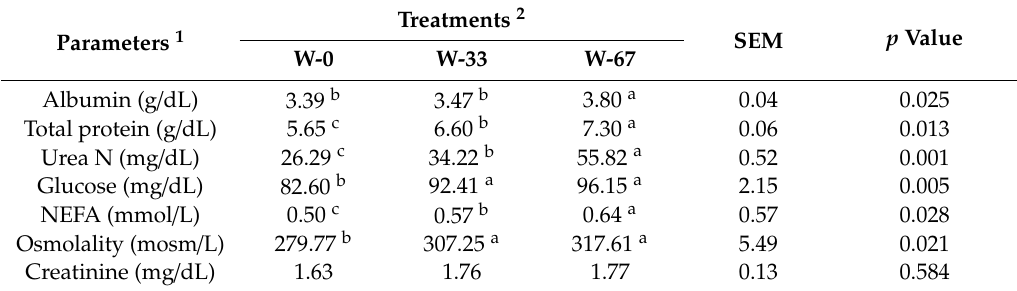
Table 6. Serum metabolites in water-restricted male Najdi lambs fed a pelleted